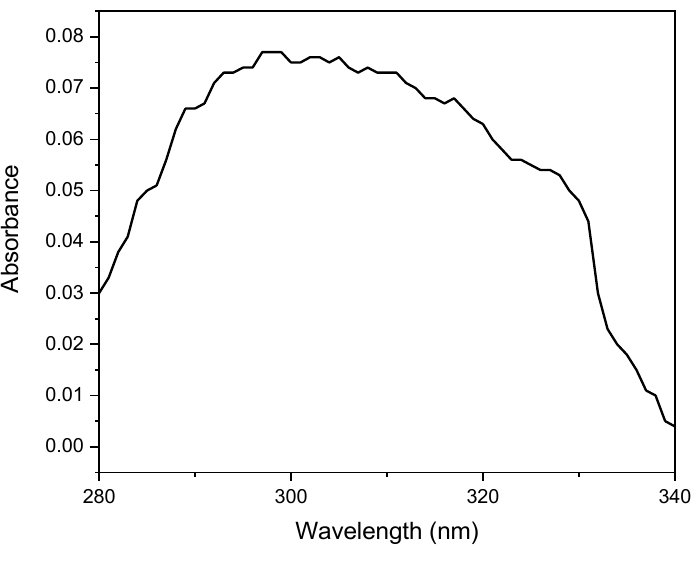
Figure 2. EDX spectrum of Zn/iron oxide NPs.